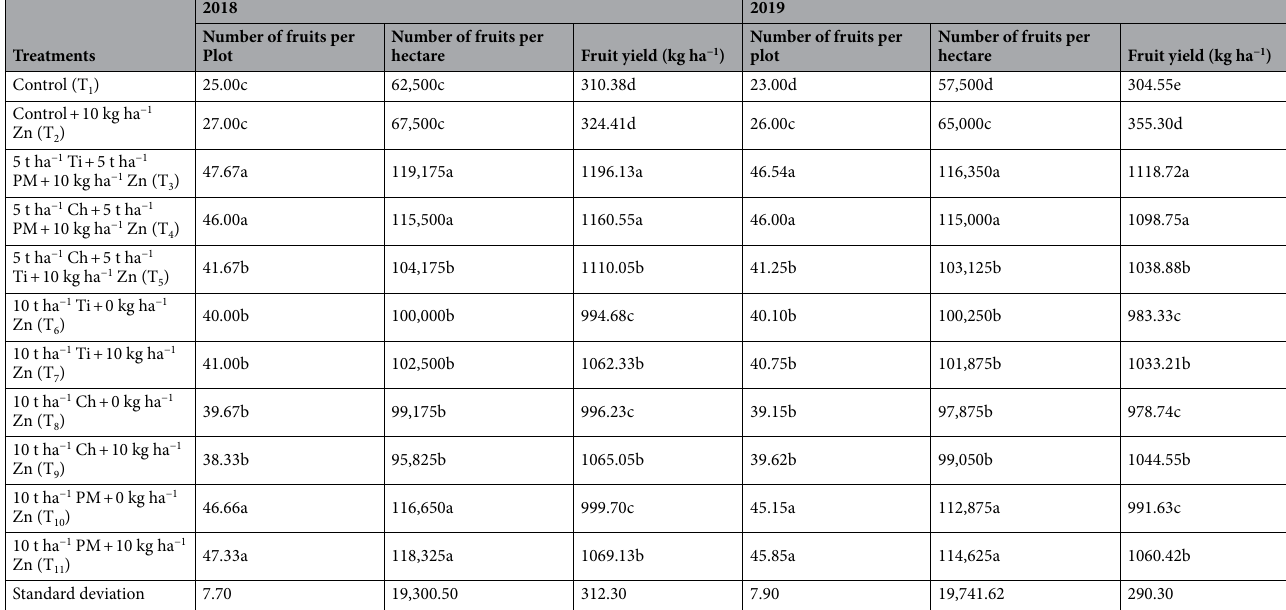
Table 4. Effects of soil applied Zn-fertilizer, green biomass and poultry manure on yield of okra in 2018 and 2019 cropping seasons. Means in a column under any given treatment followed by the same letter do not differ significantly at p ≤ 0.05 by Duncan multiple range test. Ti tithonia, Ch chromolaena, PM poultry manure.